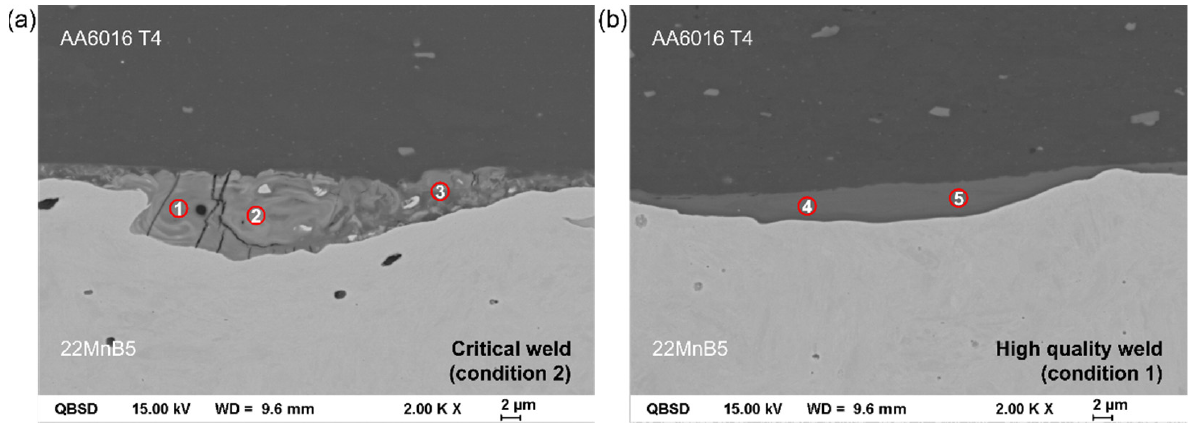
Figure 12. SEM images (BSE mode) of the joining zone of ( a ) a critical weld and ( b ) a high-quality weld with marked spots (1 to 5) for EDX point analysis.